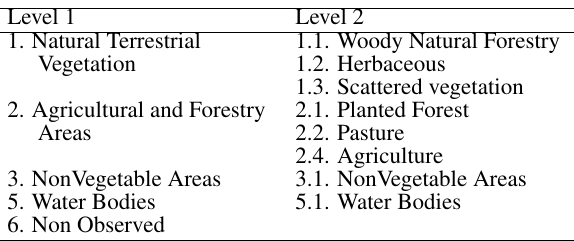
Table 1. MapBiomas Chaco mapped classes follow